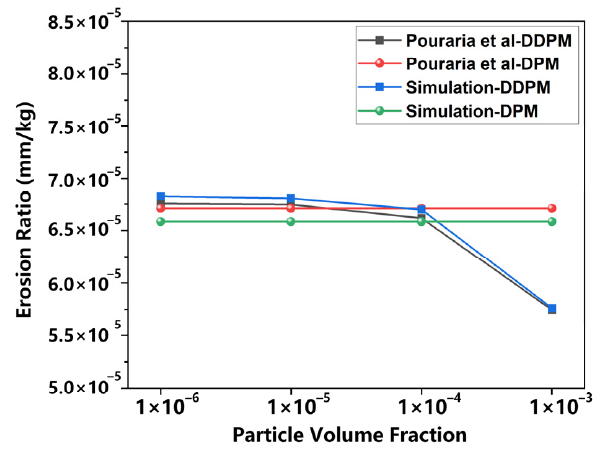
Figure 3. Comparative data of the effect of particle volume fraction on erosion rate by using the two models.